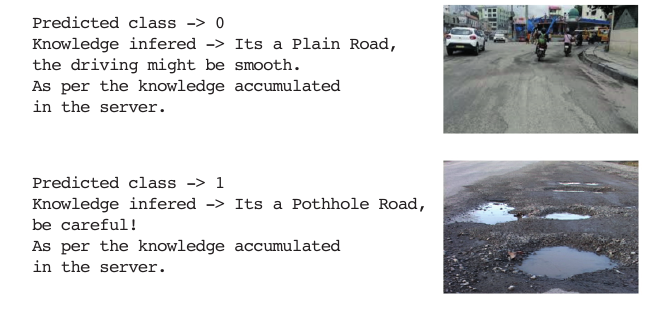
Figure 12. Road condition